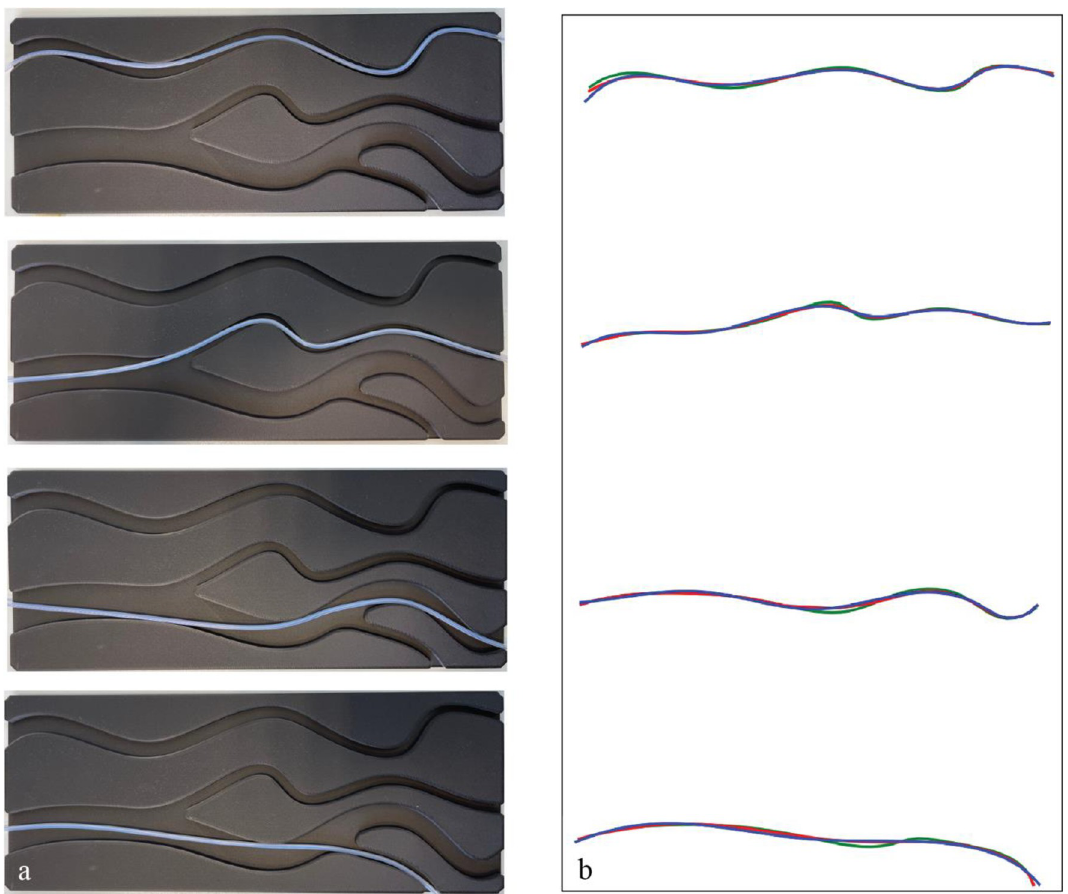
Fig 5. Test model to evaluate the FBG catheter’s flexibility, placed in 4 channels (a) and computed/acquired curves which approximate the catheter position (b): median line of channels (green), computed shape of the catheter using AIrShape software (red) and FBGS shape sensing system (blue). The red and blue curves fit on top of each other and deviate slightly from the green curve (median line) due to the rigid catheter’s tendency not to follow the median